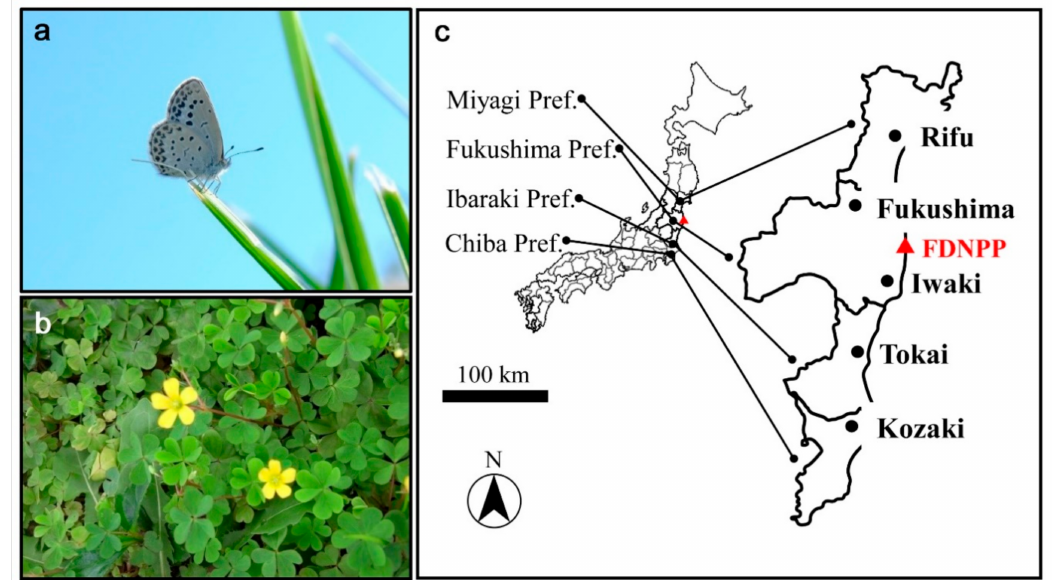
Figure 1. Organisms of interest and field work localities. ( a ) An adult individual of the pale grass blue butterfly, Z. maha ; ( b ) The host plant, the creeping wood sorrel, O. corniculata ; ( c ) Field work localities. The Fukushima Dai-ichi Nuclear Power Plant (FDNPP) is shown in